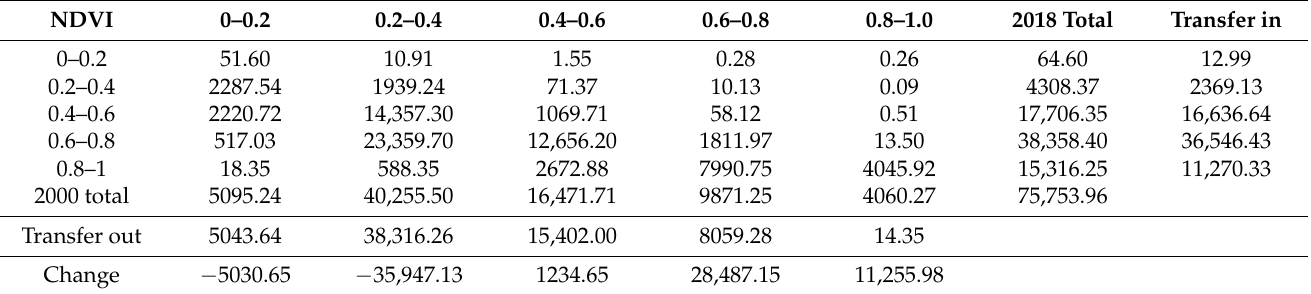
Table 3. Transfer matrix of vegetation NDVI changes in 2000 ‒ 2018 (unit: km 2 ).